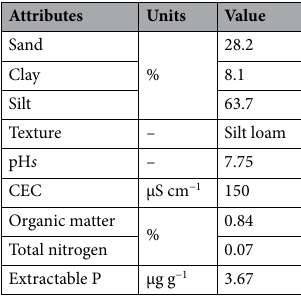
Table 5. Soil physiochemical